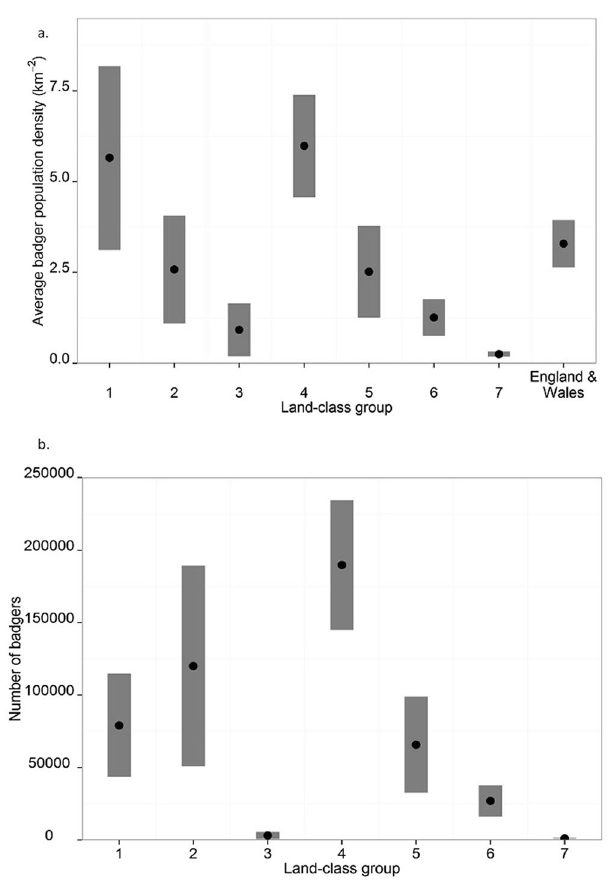
Figure 1. Estimates of badger population size ( a ) and density ( b ) in each Land Class Group. Shaded blocks indicate 95% confidence intervals for